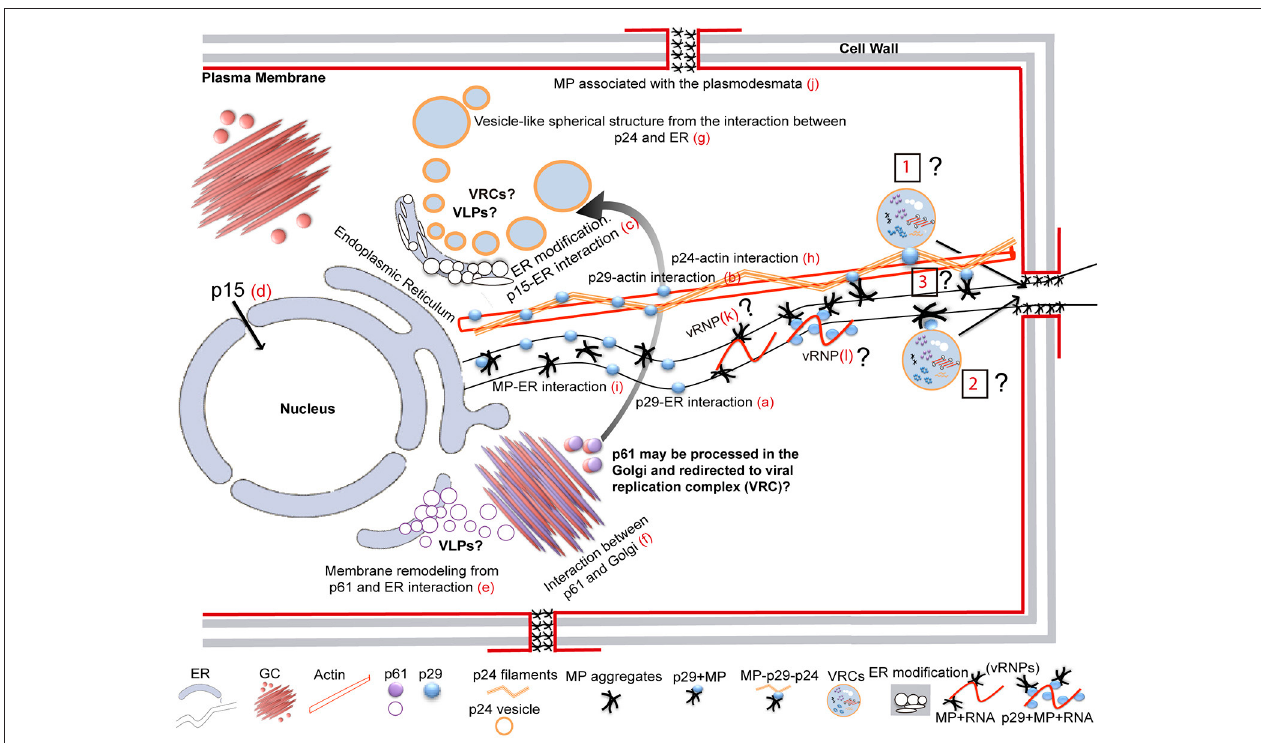
FIGURE 10 | Hypothetical model of replication, assembly and intra- and intercellular spread of citrus leprosis virus C. p29 punctate bodies are associated with cortical ER structure and actin network (a,b) . Interaction among p29 with MP and p24 are shown in these organelles. ER modification with pleomorphic formats is formed by the interaction between p15 and ER (c) . This protein is also visualized into the nucleus (d) . The p61 co-localizes with ER and GC, remodels the cortical ER and forms cytoplasmic aggregates from interaction with GC (e,f) . Vesicles-like spherical structures are formed from the interaction between p24 and ER, with the protein surrounding the ER (g) . Filament-like structures formed by p24 are wrapped around the actin filaments (h) . The movement protein associates with ER network (i) , and co-localizes with the plasmodesmata at the cell periphery (j) . In addition, curious cytopathic effects are observed by the interaction of p24 and MP proteins with Golgi complex (not shown in this scheme; see Figure 3 ). Based on our findings of CiLV-C proteins interaction, intracellular localization of the CiLV-C proteins with cortical ER/actin network and Golgi, and p29-MP trafficking, we hypothesize the region of replication and transport machinery used for CiLV-C in the cellular infection. We infer that viral replication and particle assembly occur in vesicles (that in several RNA plant viruses represent viral replication complex-VCRs), on cortical ER formed from p24 and p15 ER membrane association. In general, VRCs are formed by RNA, viral proteins and host membrane and proteins, not yet determined for CiLV-C. During viral replication, the p61 (suggested here to be the viral glycoprotein) could be processed in the GC and redirected to VCRs on cortical ER for assembly of the virion envelope. Virus-like particle (VLPs) could be formed by p24 and p61, given their ability in ER membrane remodeling. For trafficking of VRCs and/or ribonucleoprotein complex (vRNP) from the replication site to cell periphery, we suggest different possibilities: (i) the p29, together with p24, would ensure the anchoring of vRNP, VRC or sub-complexes in the actin cytoskeleton, guiding their trafficking along the filaments to cell periphery [1]; (ii) by ER trafficking, where the action of the MP with